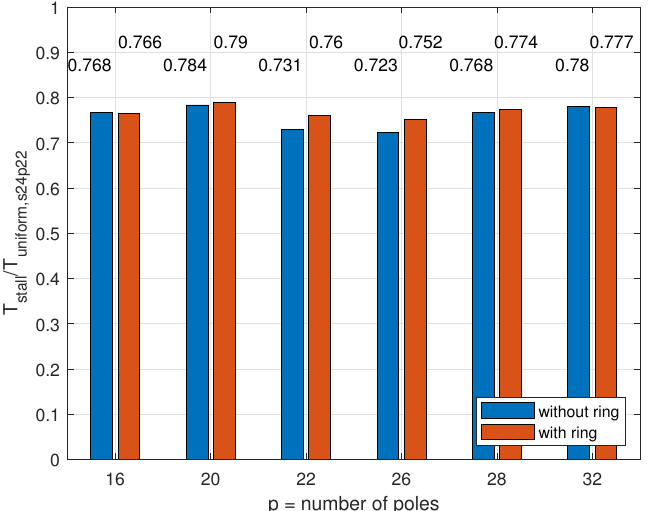
Figure 15. Measured torque derating factor T stall / T uniform,s24p22 for various slot/pole combinations and for the case with and without thermal end-winding